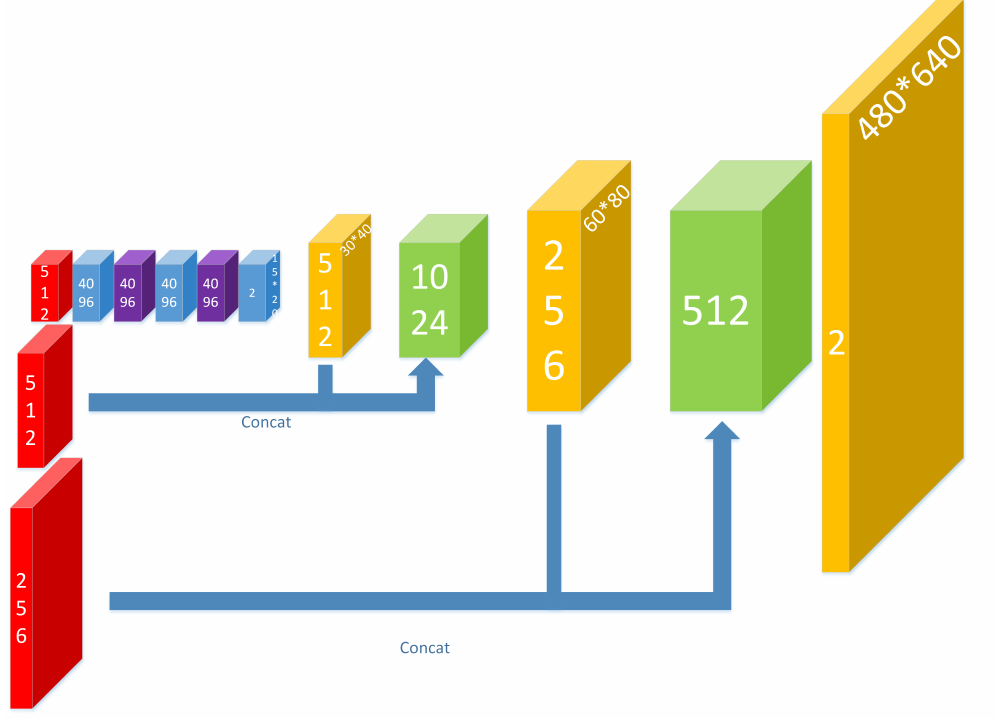
Figure 5. The maps of the heat map network in our approach. Red ones are obtained from the last stage, blue ones from convolutional layers, purple ones from dropout layers, yellow ones from deconvolutional layers and green ones from concat